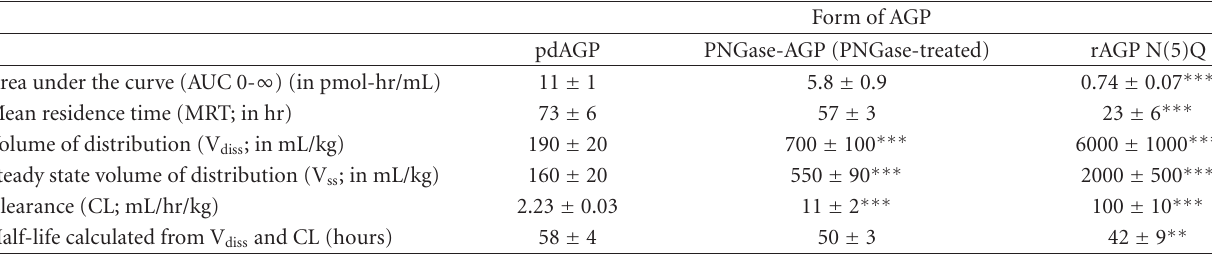
Table 1: Pharmacokinetic parameters relating to AGP clearance in rabbits.